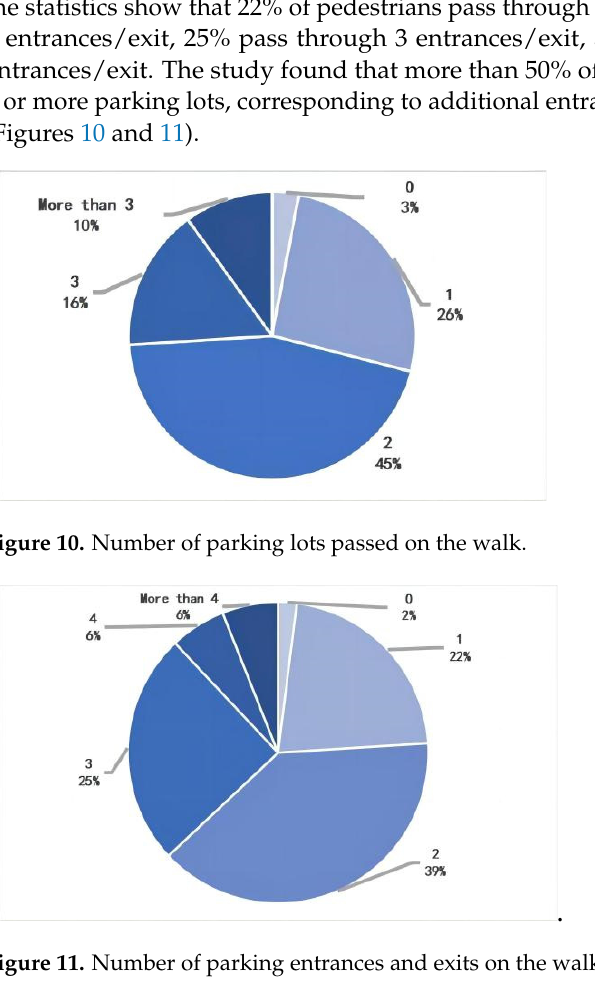
Figure 11. Number of parking entrances and exits on the walk.